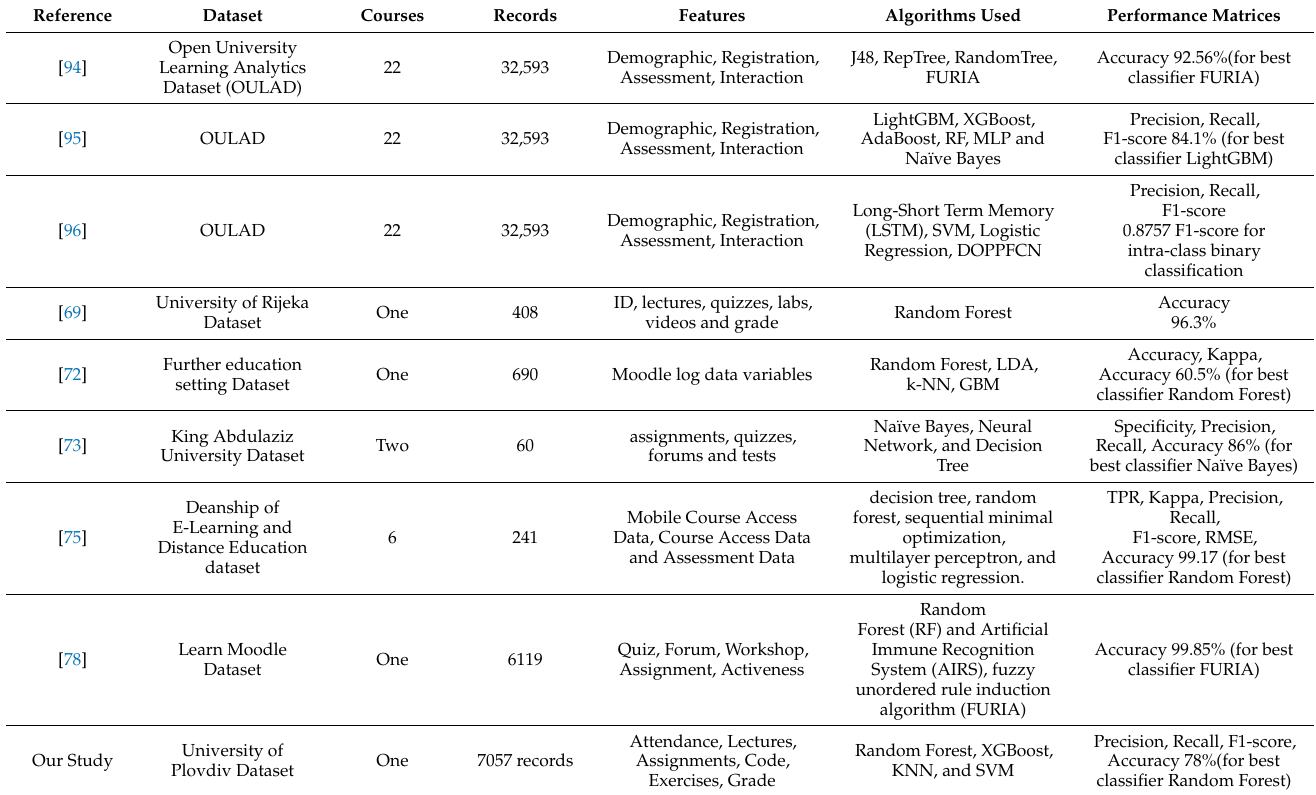
Table 7. Comparison of our study with some of the existing works in the